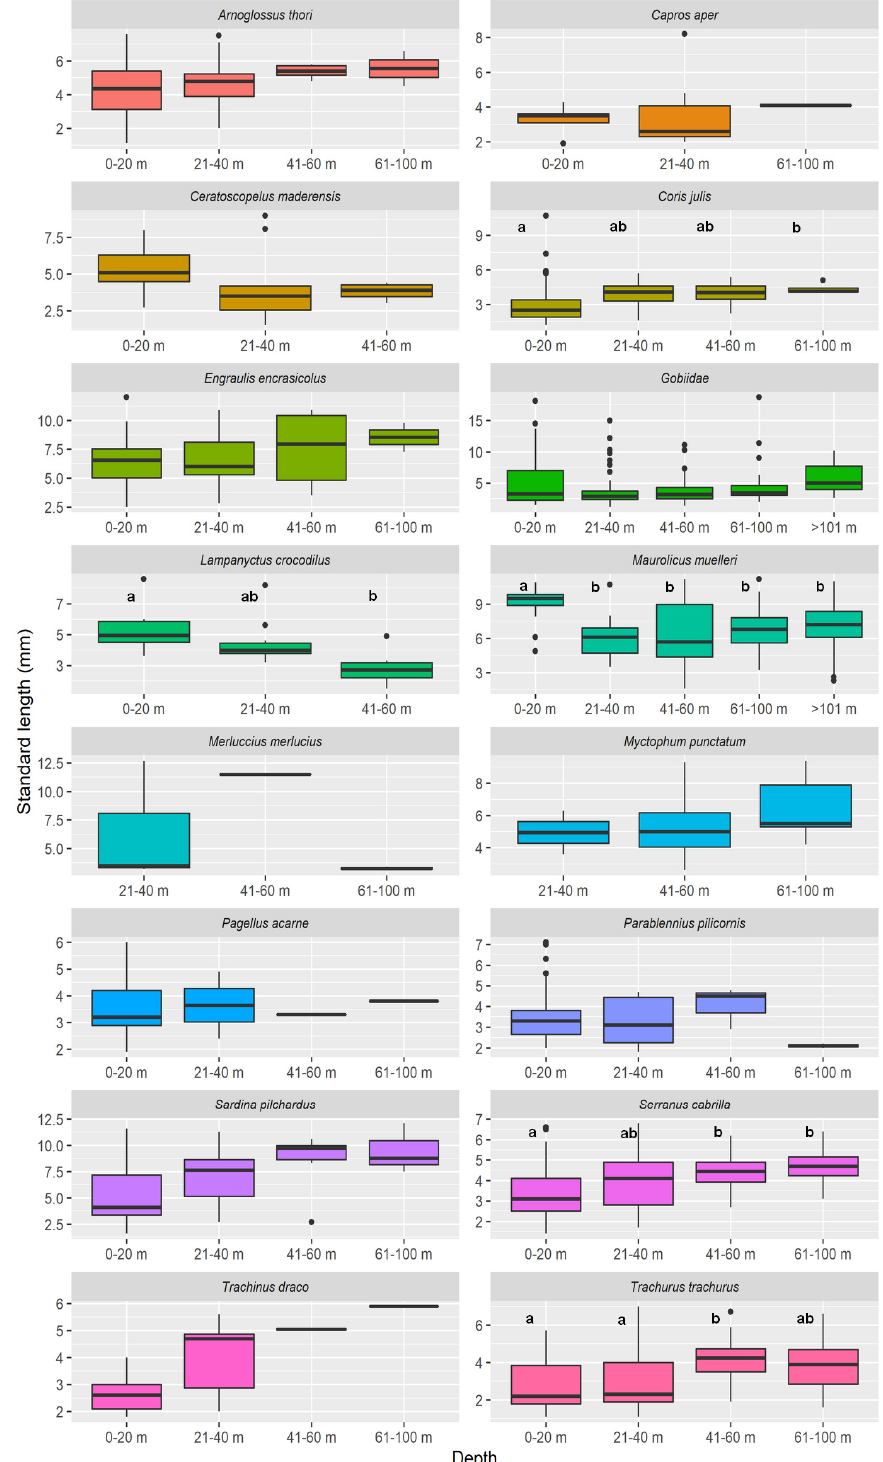
Figure 8. Length distribution of fish larvae at varying depths. Line: median; box: 1st and 3rd quartiles; whiskers: maximum and minimum values; black dots: outliers. The results of the Tukey post hoc test ( α = 0.01) for differences in larval length of the most abundant taxa by depth are indicated by the letters a and b to define the groups that are significantly different from each other; groups sharing a letter are not significantly different.